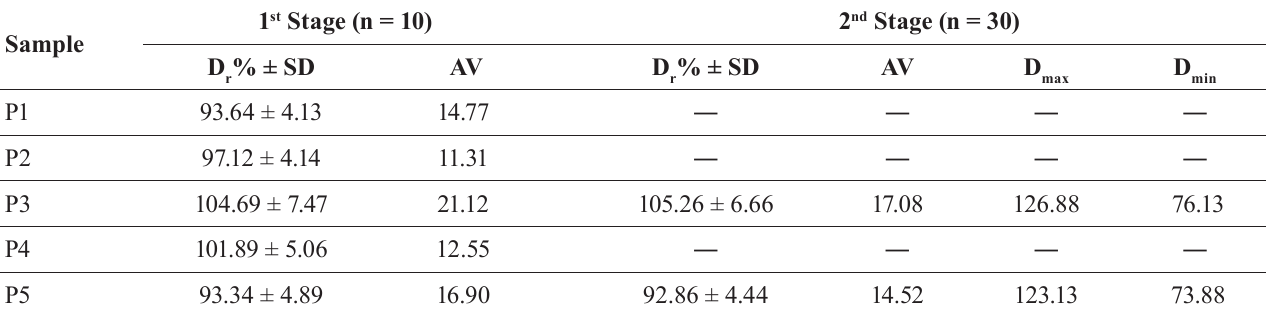
%) in first and second stage, calculated by weight r